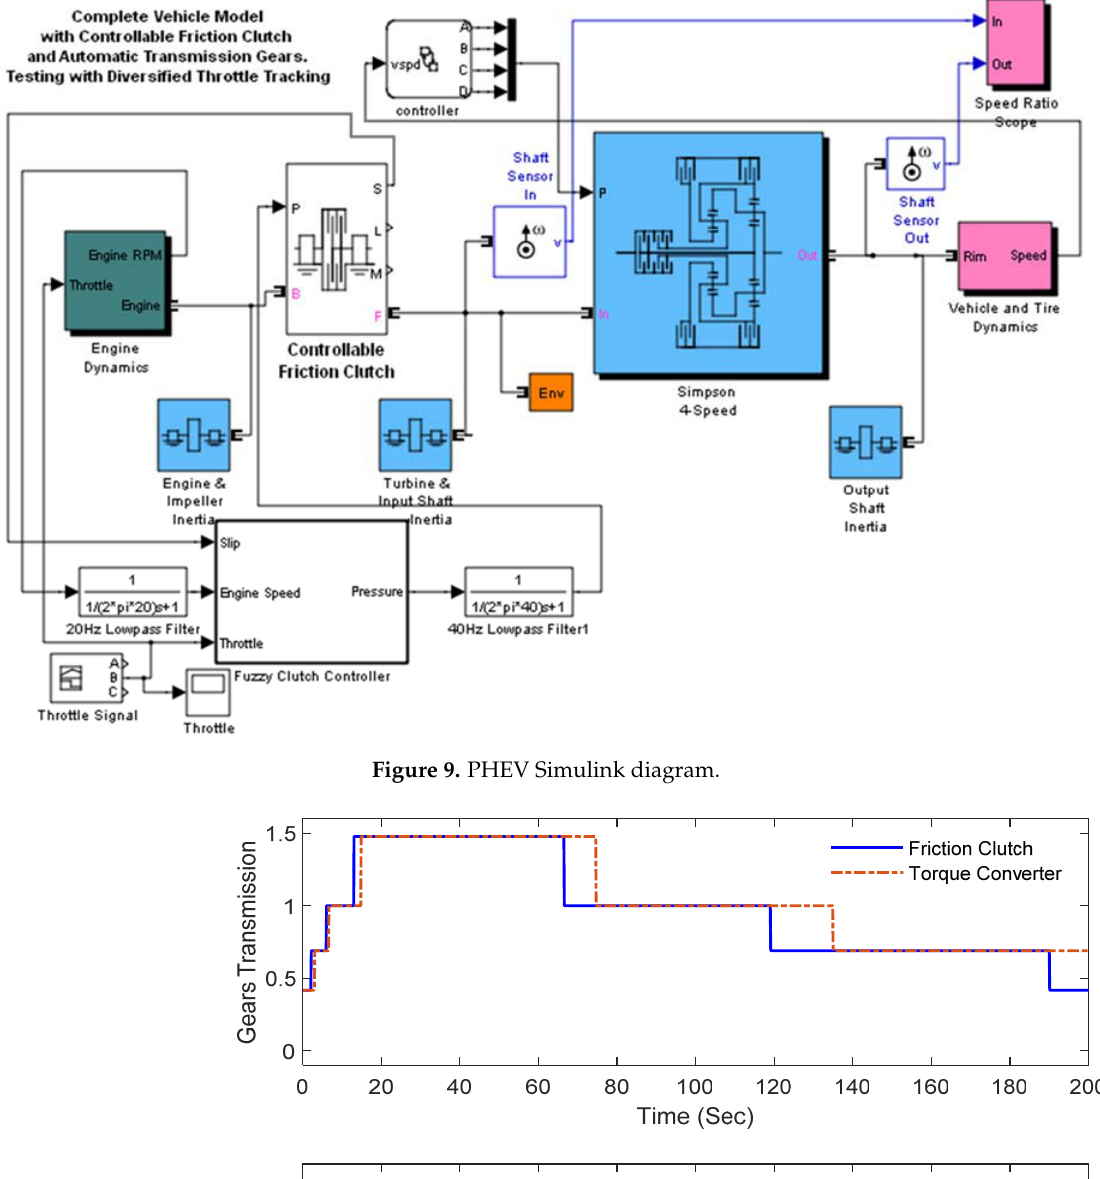
9 of 16 Figure 8. Fuzzy logic controller.